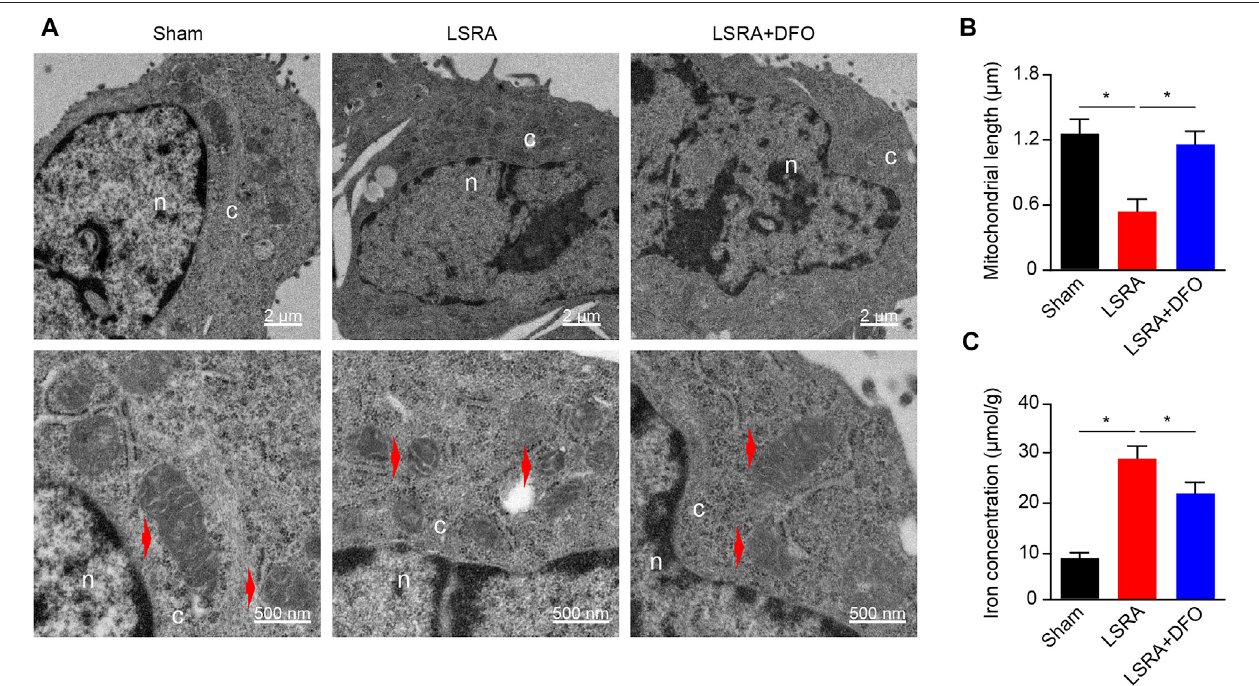
FIGURE 1 | Induction of ferroptosis in spinal cord tissue after LSRA. (A) Transmission electron microscopy of spinal cord tissues obtained from rats in the Sham, LSRA, and LSRA + DFO groups. Scale bars: upper, 2 μ m; lower, 500 nm. Red arrows indicate mitochondria. (B) Average mitochondrial length (along the long axis) was measured in different groups, n = 60mitochondria/group. (C) Totaliron levelof spinalcord tissue was detected in differentgroups. n = 10 rats/group. Signi fi cance in (B and C) was calculated using the one-way ANOVA with Tukey ’ s posthoc test; * p < 0.05. Abbreviations: Sham, sham-operated rats; LSRA, lumbosacral spinal root avulsion; and DFO,